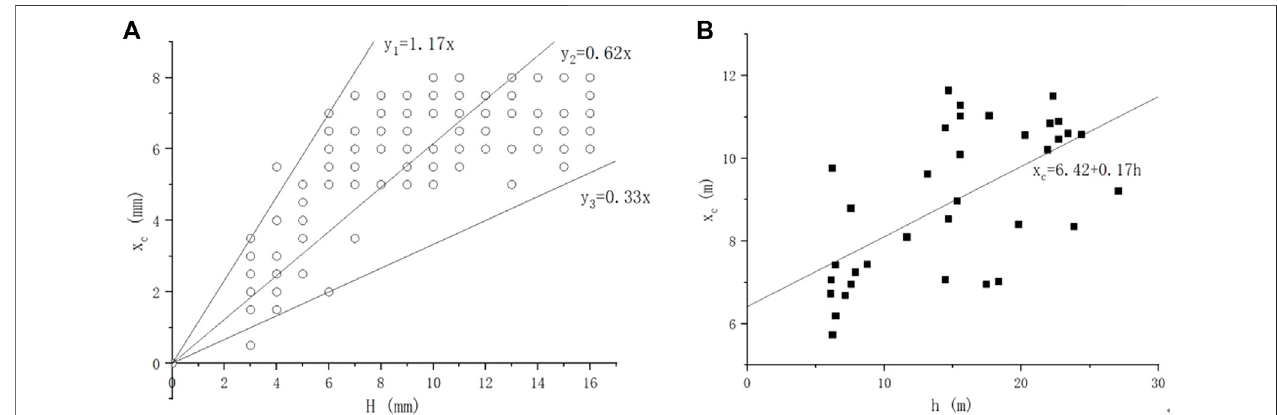
FIGURE 7 | Parameters relationship: a x c − H relationship; b x c − h relationship.